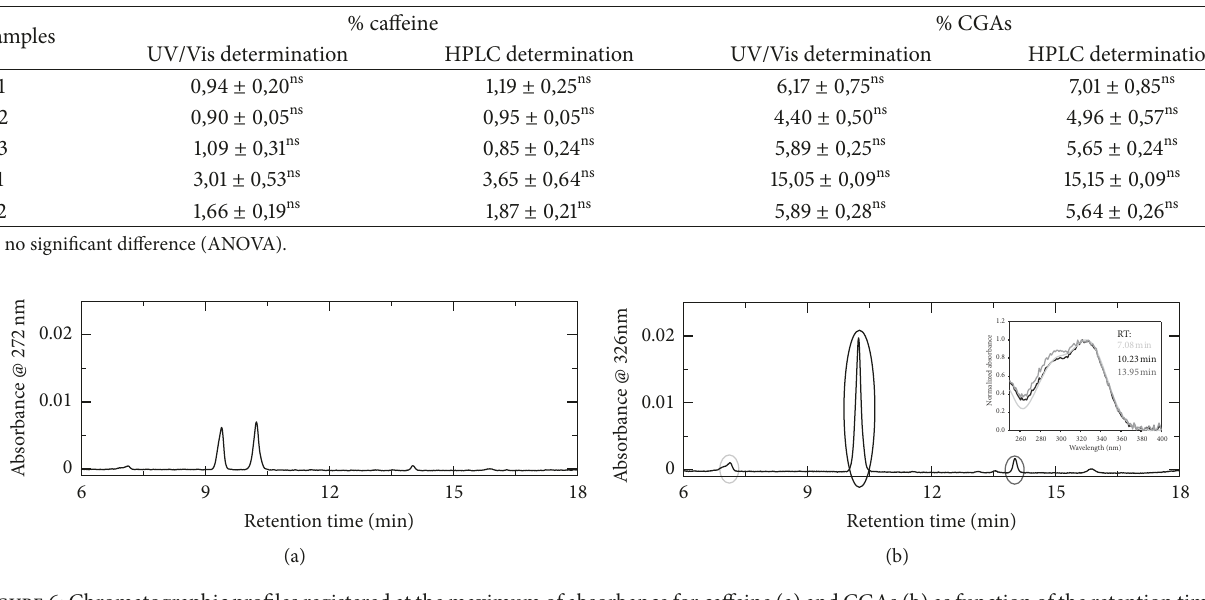
Table1:PercentquantificationofcaffeineandCGAsintogroundcoffeeofArabica(A1,A2,andA3)andRobusta(R1andR2)coffeeasobtained byapplyingUV/VisabsorptionandHPLCmethods. Errorassociatedwithcalculatedconcentrationvaluewasthestandarddeviationobtained from triplicate measurements.